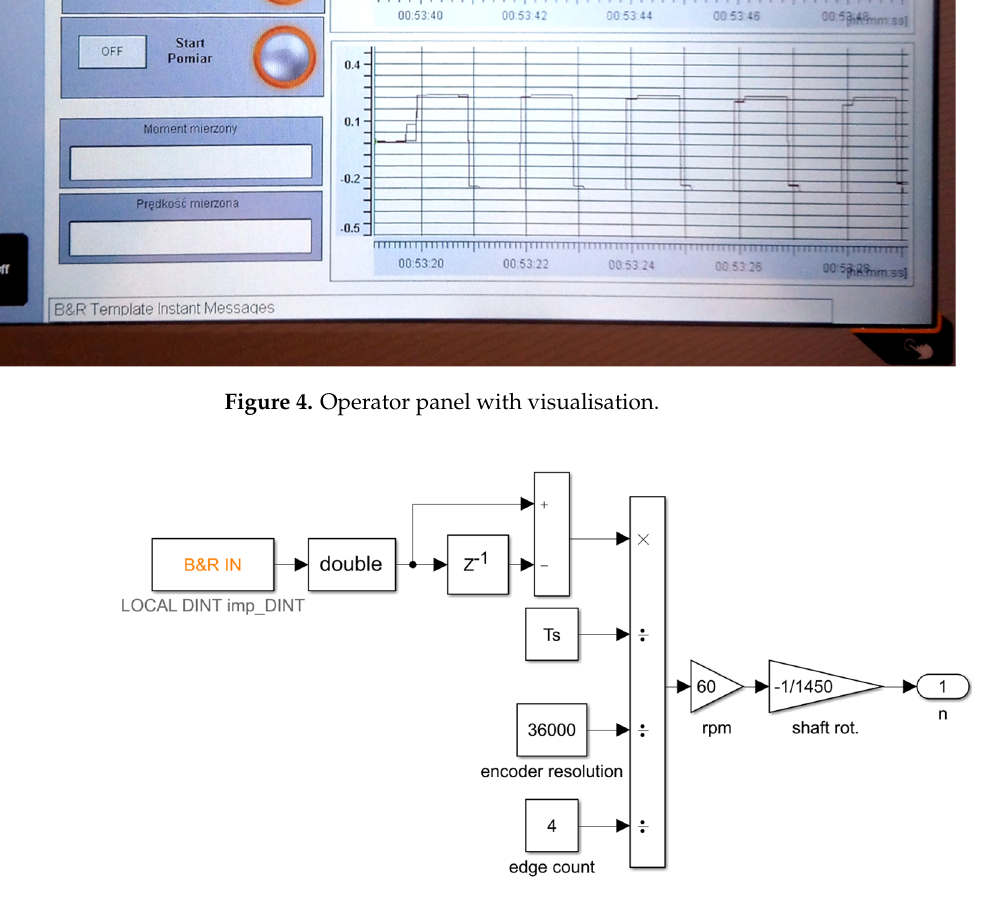
Figure 5. Speed calculation algorithm.